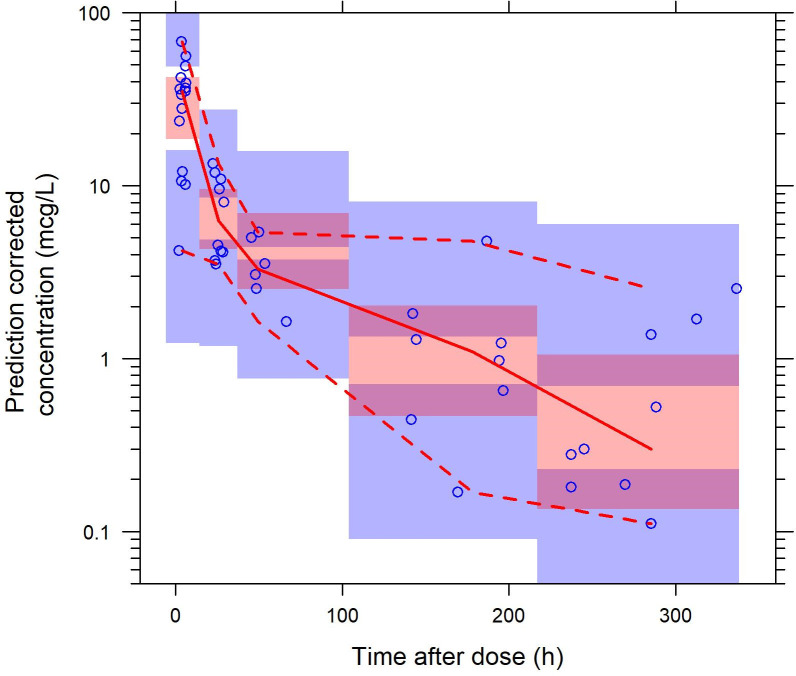
Prediction-corrected visual predictive check.The open circles are observed concentrations. The dashed lines are the 10th and 90th percentiles of the model predictions and the solid line is the 50th percentile. The bands are the 95% CI of the percentiles of the model predictions.